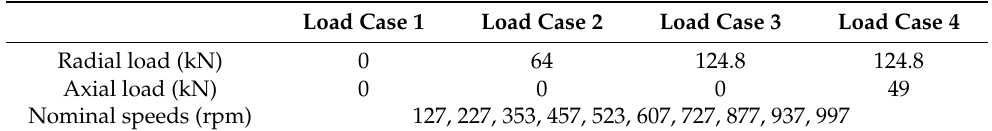
Figure 6. SKF 22,240 CCK/W33: ( a ) normal state bearing during dismounting; ( b ) inner race damage with 2 mm diameter and 0.5 mm depth; ( c ) outer race damage with 2 mm diameter and 0.5 mm depth. Table 4. Test conditions.